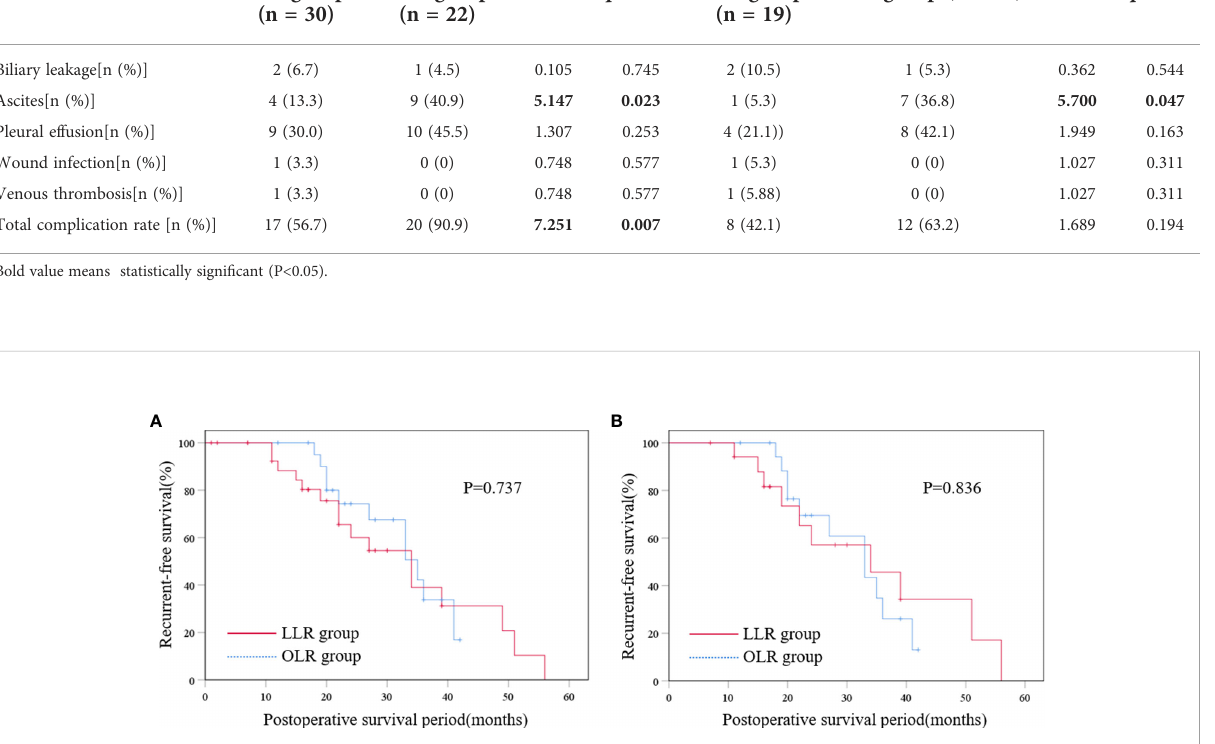
FIGURE 2 Disease-free survival curve of the two groups before PSM (A) and Disease-free survival curve of the two groups after PSM (B) . LLR laparoscopic liver resection, OLR open liver resection, PSM propensity score